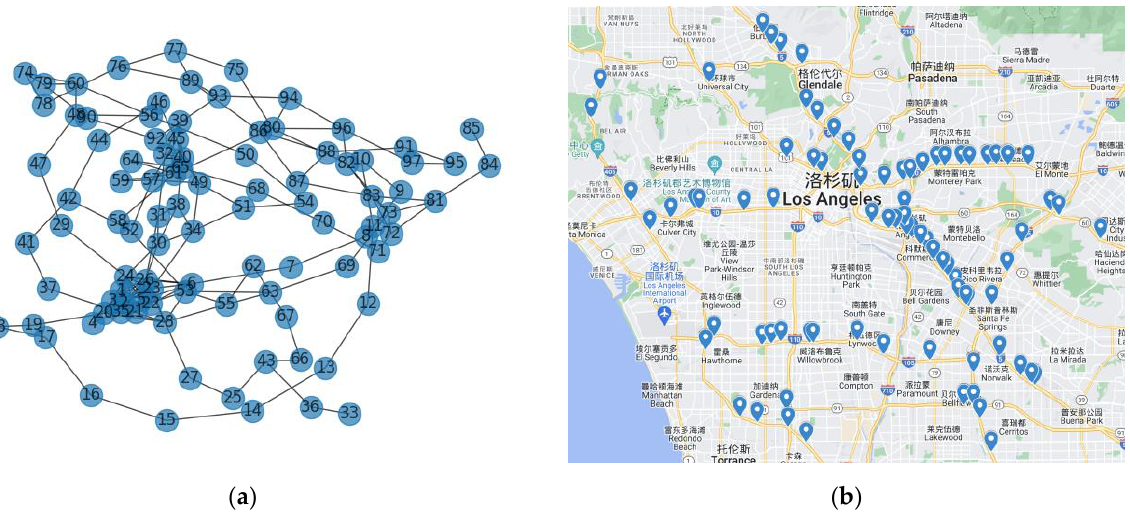
Figure 1. Traffic complex network structure and node location. ( a ) Traffic complex network structure; ( b ) The geographical location of the 97 monitoring stations.